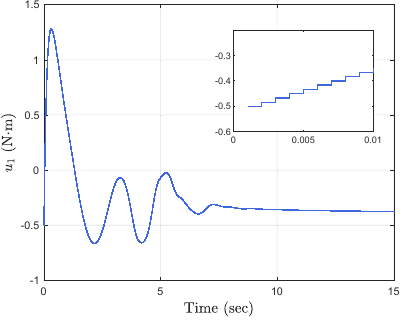
Figure 12. Time − triggered control input u 1